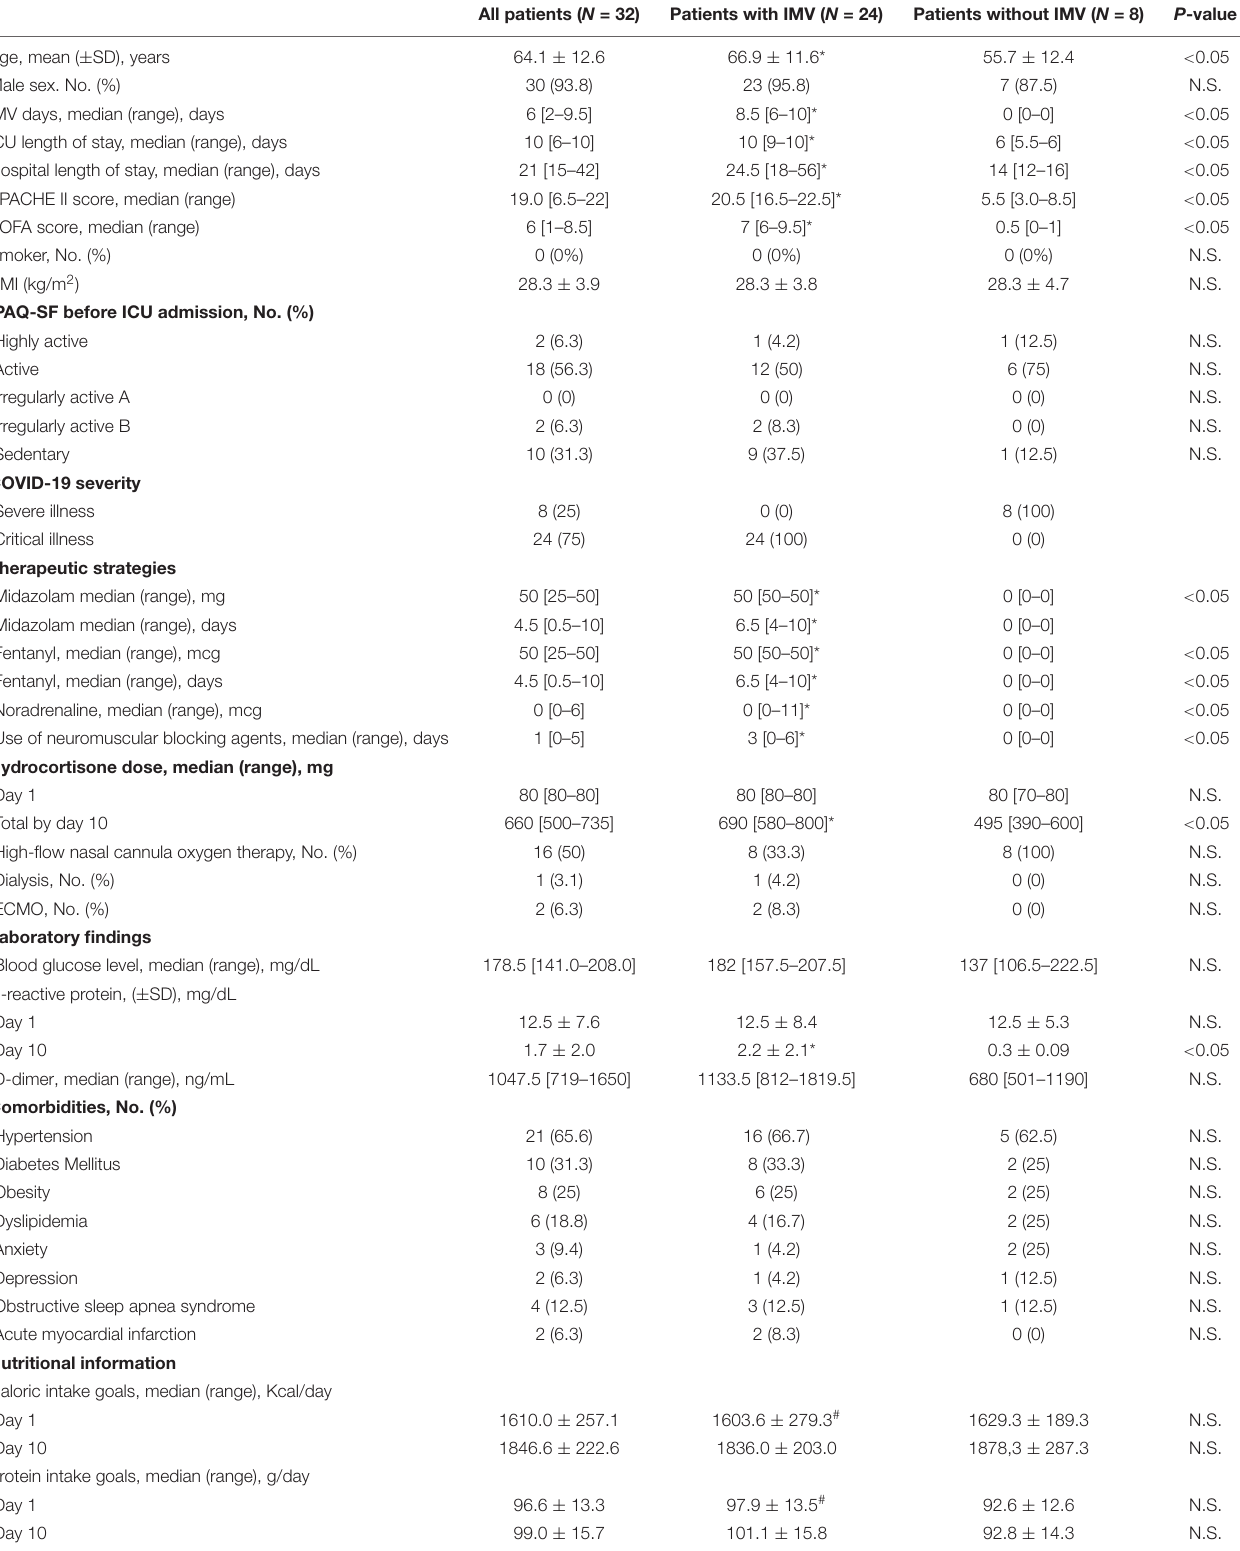
TABLE 2 | Demographic and clinical characteristics of the patients. All patients ( N = 32) Patients with IMV ( N = 24) Patients without IMV ( N = 8) P